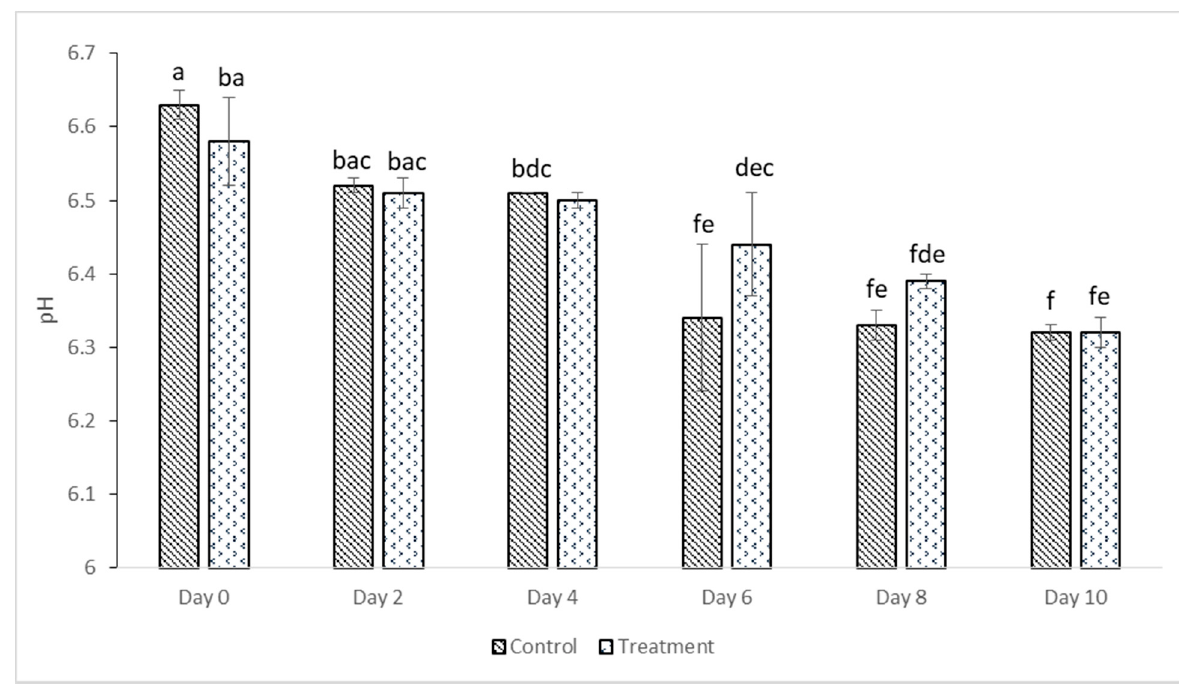
Figure 4. pH values of control and treated deep-fat-fried chicken samples. Data are given as mean values ± standard deviation. Different letters on the top of data bars indicate significant differences (Tukey’s test, p < 0.05) between mean values.